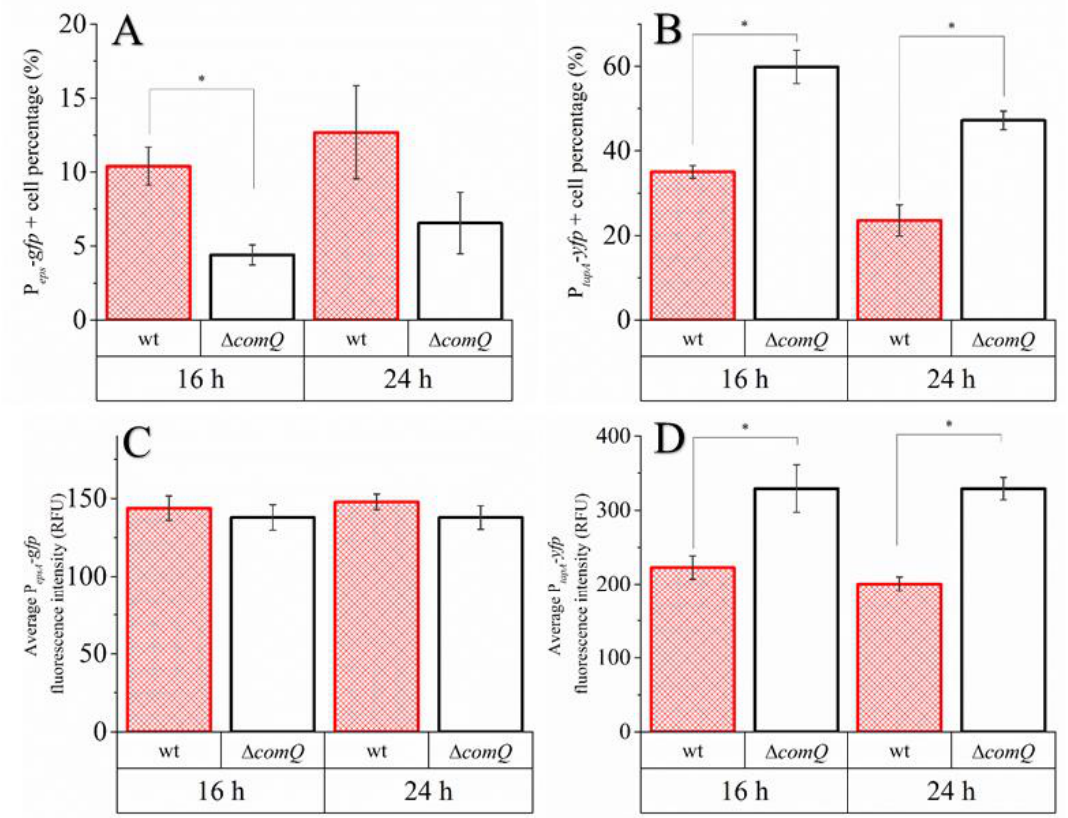
Figure 5. Comparisons of single-cell P epsA (wt; BM1103 and Δ comQ ; BM1458) and P tapA (wt; BM1115 and Δ comQ BM1126) promoter activity in B. subtilis PS-216 during static growth in MSgg medium at 37 ◦ C. ( A ) Percentage (relative to total cell count) of wild type phenotype (wt) and QS mutant ( ∆ comQ ) cells expressing from P epsA . ( B ) Percentage (relative to total cell count) of cells expressing from P tapA . ( C ) Average fluorescence intensity of cells expressing from P epsA . ( D ) Average fluorescence intensity of cells expressing from P tapA . Data points represent averages with the standard error of means (SEM) of three biological replicates. Statistical significance (marked with *) was determined using a one-way Mann –Whitney test and a Student’s t -test ( p < 0.05).